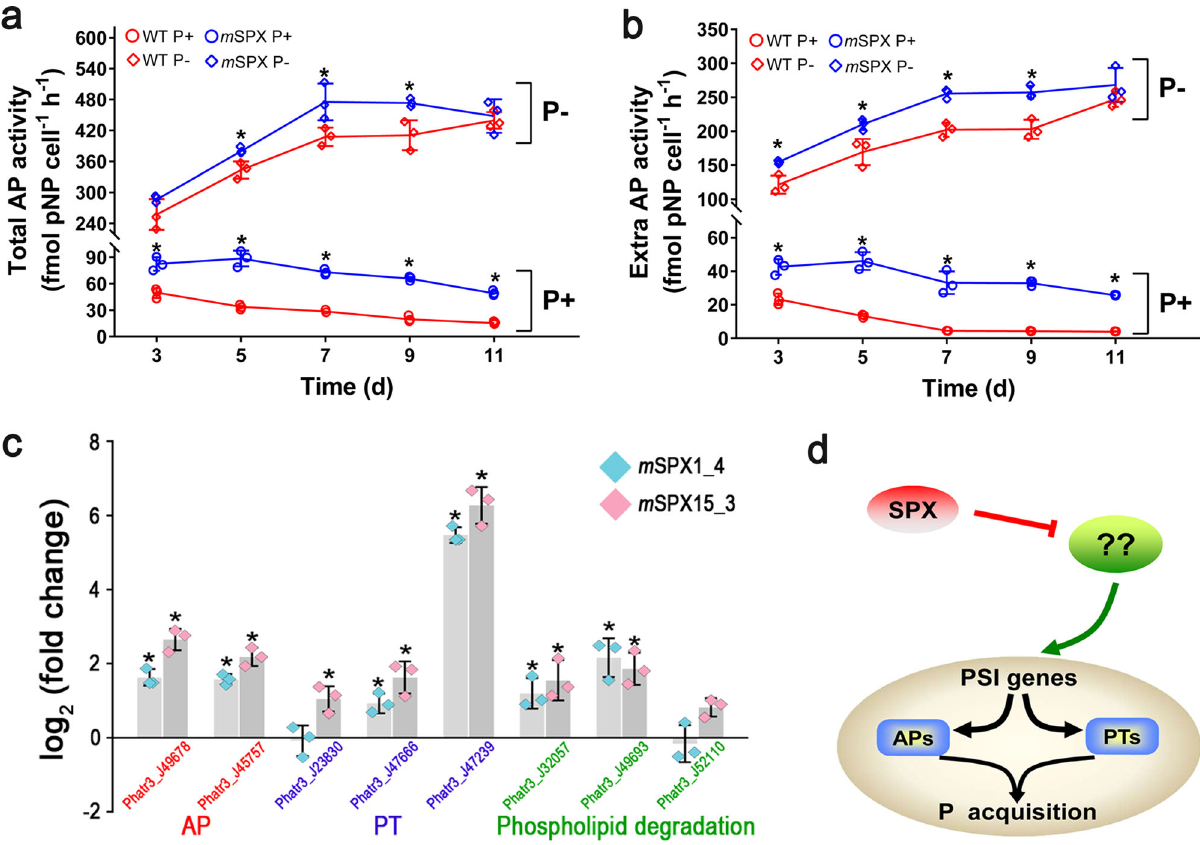
Fig. 3 Evidence that SPX is an upstream negative regulator of AP and P transporters. a Total AP activities in m SPX15-3 were higher than in WT. b Extracellular AP activities in m SPX15-3 were higher than in WT. Error bars, SD. Asterisks in ( a , b ) depict signi fi cant differences ( n = 3; p < 0.05). c Changes in mRNA expression of AP, PT, and phospholipid degradation-related genes between SPX mutants ( m SPX1-4 and m SPX15-3) and WT under P + condition. Error bars, SD. Statistically signi fi cant changes (*) relates to comparison of m SPX with WT ( n = 3; p < 0.05). d The putative model of SPX as an upstream negative regulator in P. tricornutum . Positive and negative effects are indicated by arrows and fl at-ended lines,